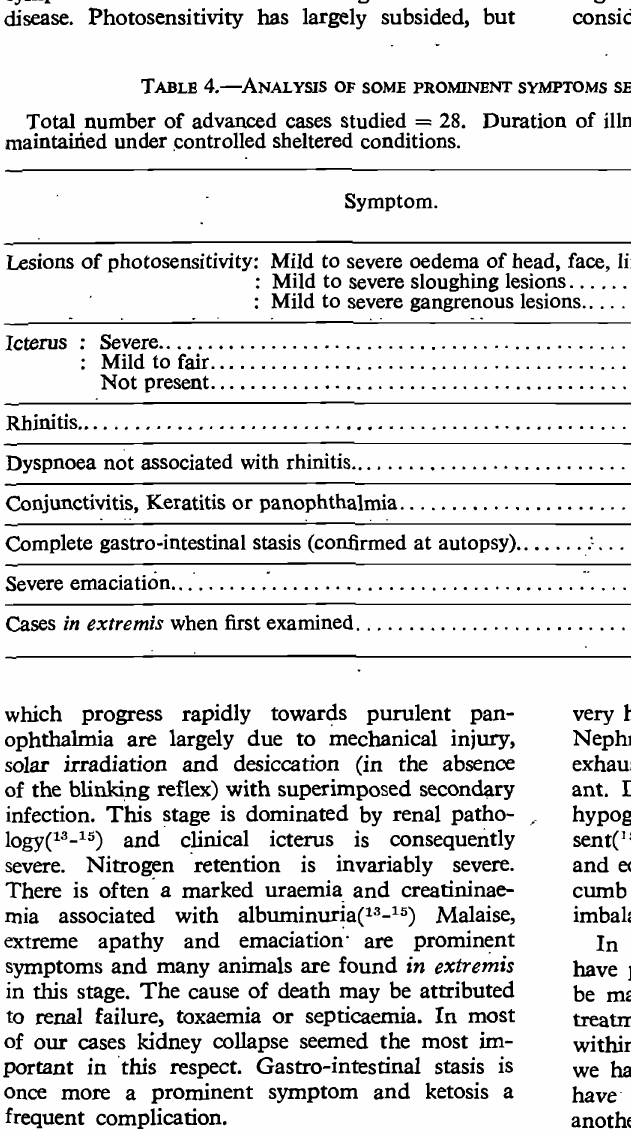
TABLB 4.-ANALYSIS OF SOME PROMINBNT SYMPTOMS SEBN IN BARLY CASES OF